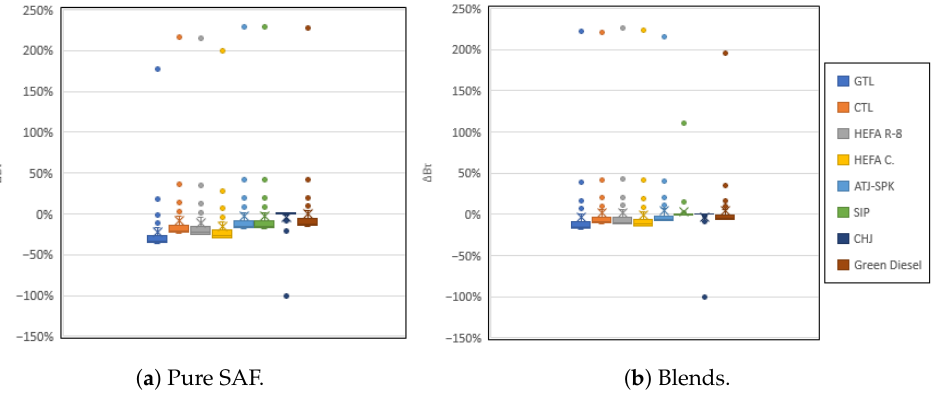
Figure 20. RDs in the product of contrail width by contrail optical depth for ambient relative humidi- ties at formation in the range of 40% to